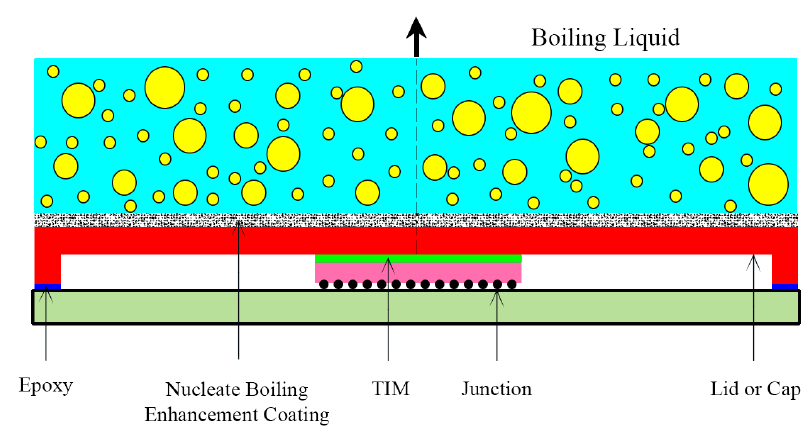
Figure 2. Application of pool boiling in systems utilized for cooling electronic chips.